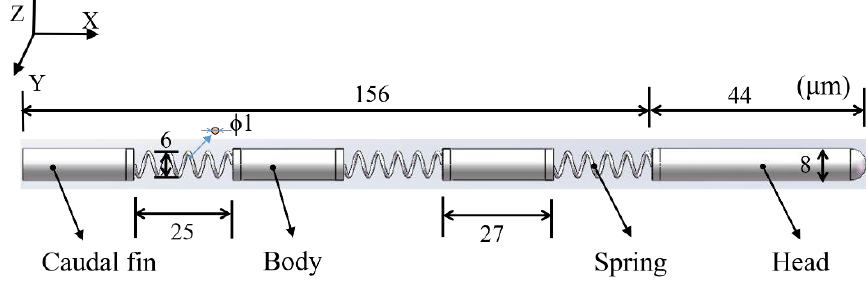
Figure 1. Schematic of the designed microswimmer.